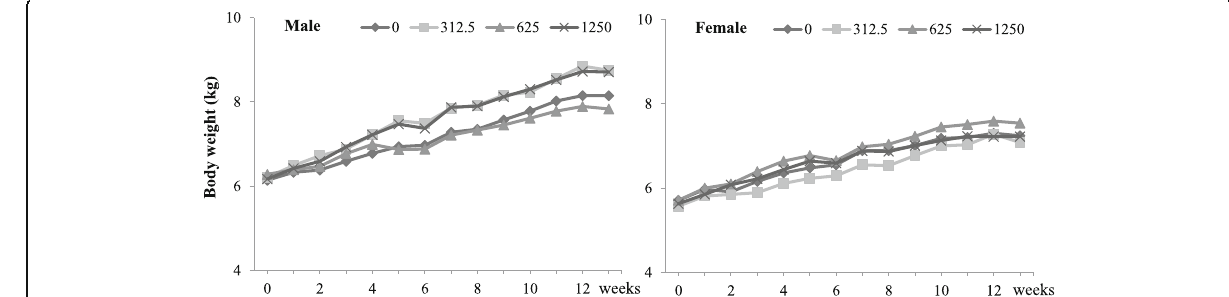
Fig. 2 Body weight changes of dogs after 13 weeks. There were no significant differences in the body weight in the groups administered with Myelophil compared with the control group during the study